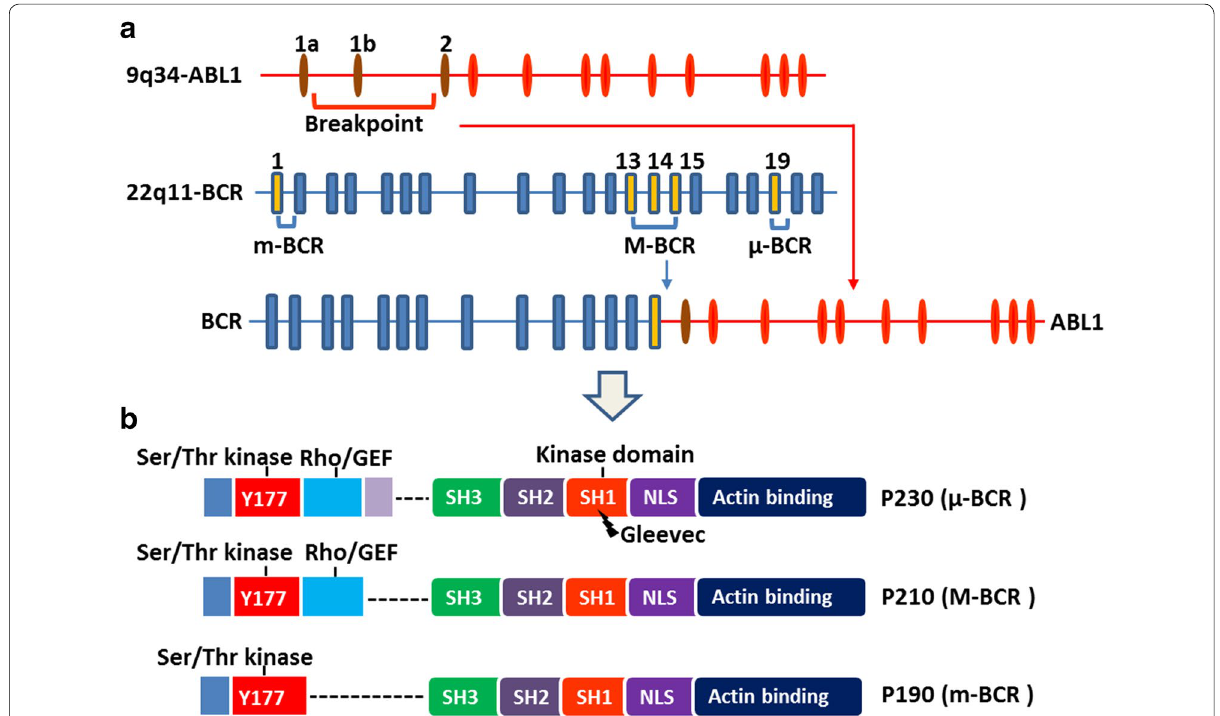
Fig. 1 The structure of the breakpoint cluster region ( BCR )‑proto‑oncogene tyrosine‑protein kinase ( ABL1 ) gene and protein. a The BCR ‑ ABL1 fusion gene consists of the 5 ′ end of the BCR gene located at 22q11 and the 3 ′ end of the ABL1 gene located at 9q34. The breakpoints of the translocation usually involve the intron 13 or 14 of BCR , named major breakpoint (M‑BCR), intron 1 of BCR , named minor breakpoint (m‑BCR), and exon 19 of BCR , named μ breakpoint (μ‑BCR). For ABL1 , the breakpoint always involves the region between exons 1b and 2. b The BCR‑ABL1 protein contains the Ser/Thr kinase domain and the Rho/GEF domain of BCR and the src homology (SH) domains, nuclear localization signal (NLS), and actin‑binding domains from ABL1. The SH1 kinase domain is the target of imatinib. The different breakpoints that generate the p230, p210, and p190 isoforms are